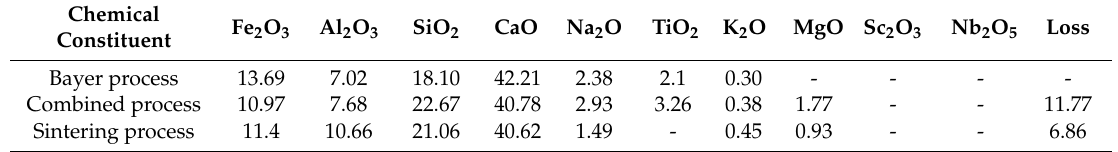
Table 1. Chemical compositions of RM using di ff erent production methods (%). Reproduced with permission from [23], published by Elsevier Ltd., 2017.